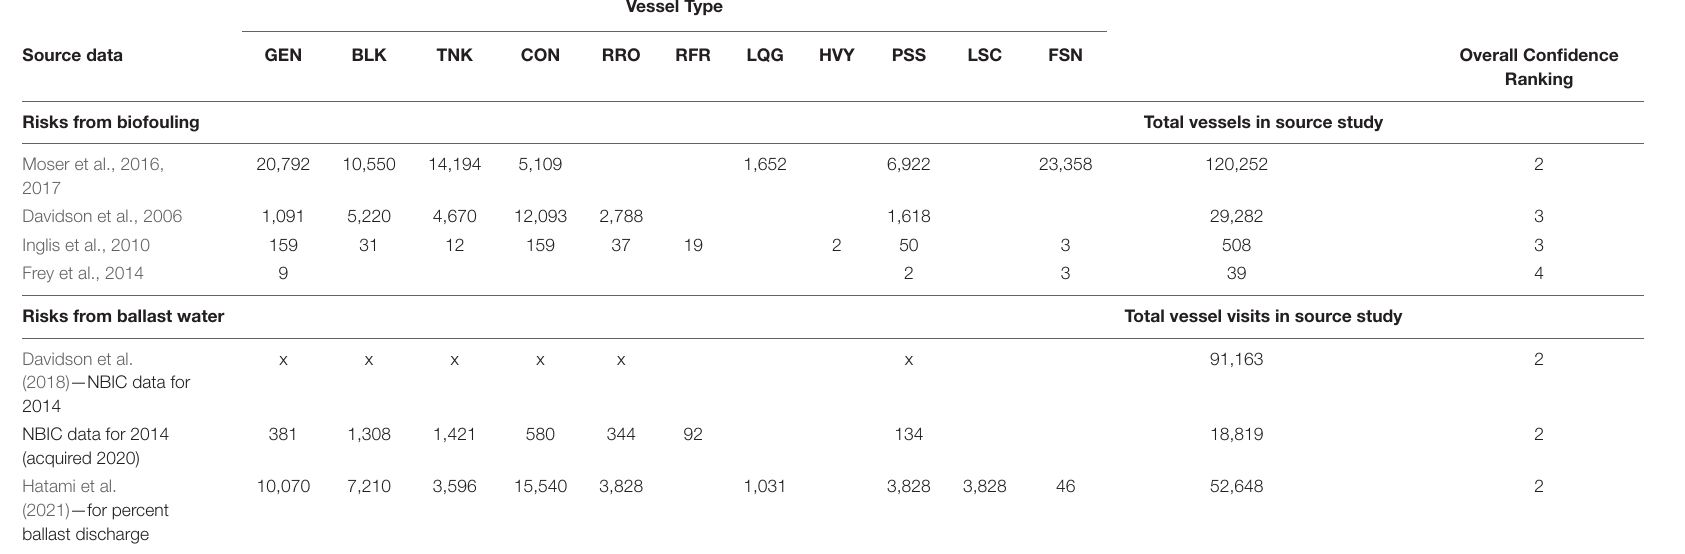
TABLE 2 | Overview of data sources included in the vessel biosecurity risk